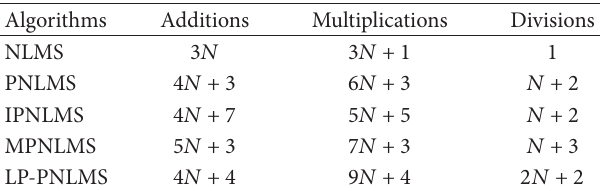
Table 1: Computational